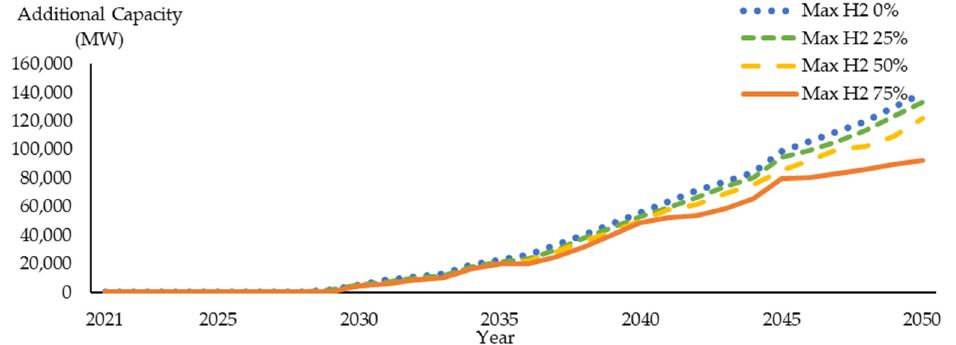
Figure 13. Additional capacity of each scenario.